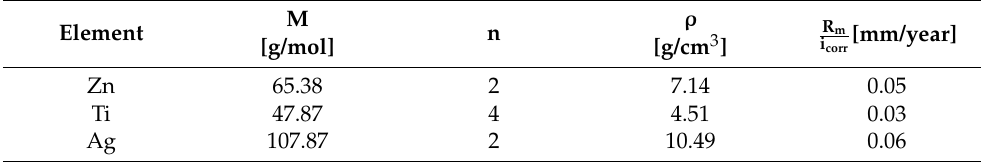
Figure 3. Example of a Tafel fitting on log current-potential curve. Table 1. Values for calculating the corrosion rate per year for each element according to Faraday’s law.